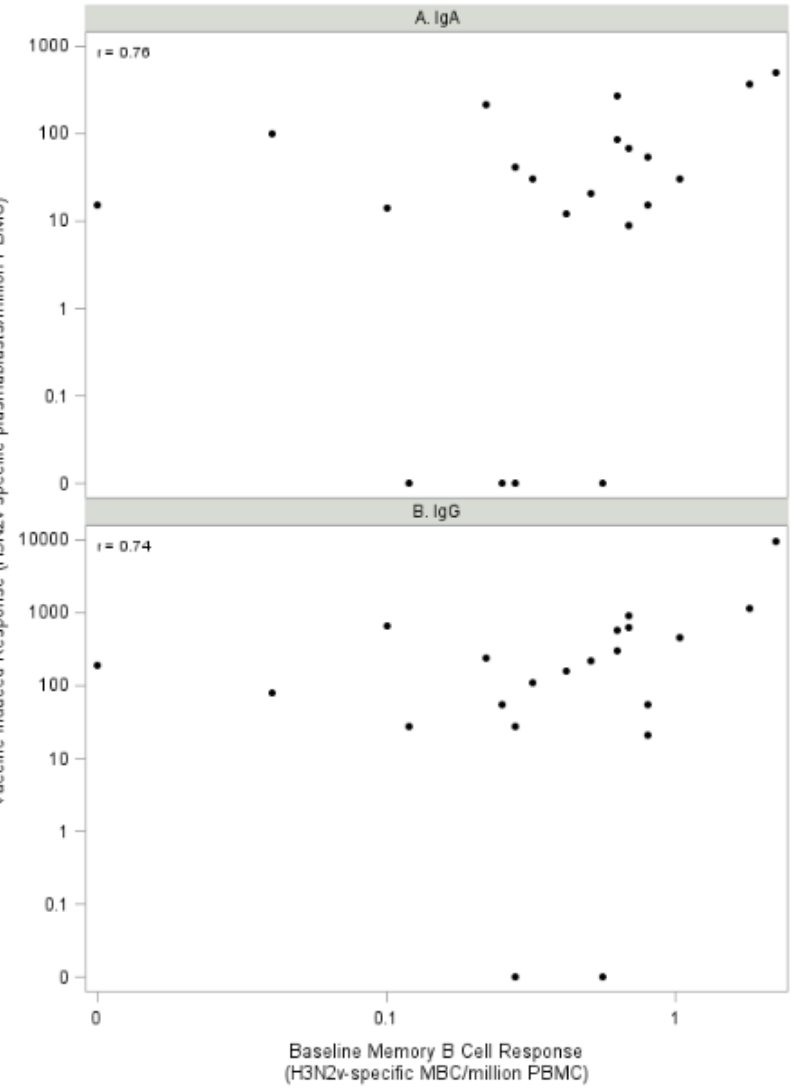
Figure 2. Percentage of MBCs producing H3N2v-specific IgG at baseline (Day 0) correlates with Day 8